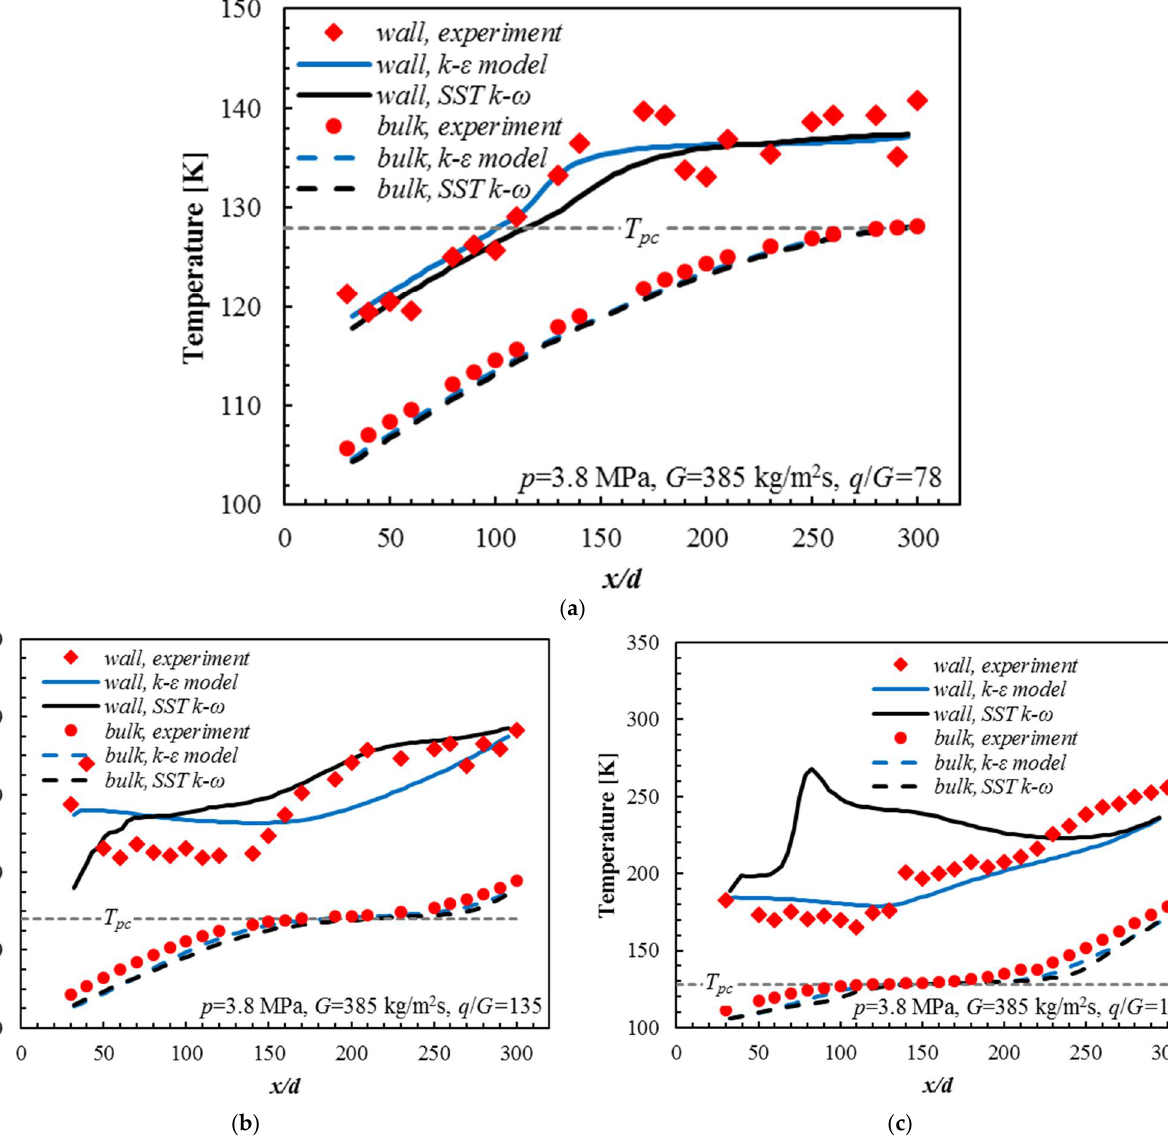
Figure 4. Comparison of the inner wall and bulk fluid temperature profiles along the tube between experimental and simulation results with different turbulence models for various values of q / G (Unit: J/kg) at p = 3.8 MPa and T in = 101 K: ( a ) q / G = 78; ( b ) q / G = 135; and ( c ) q / G =